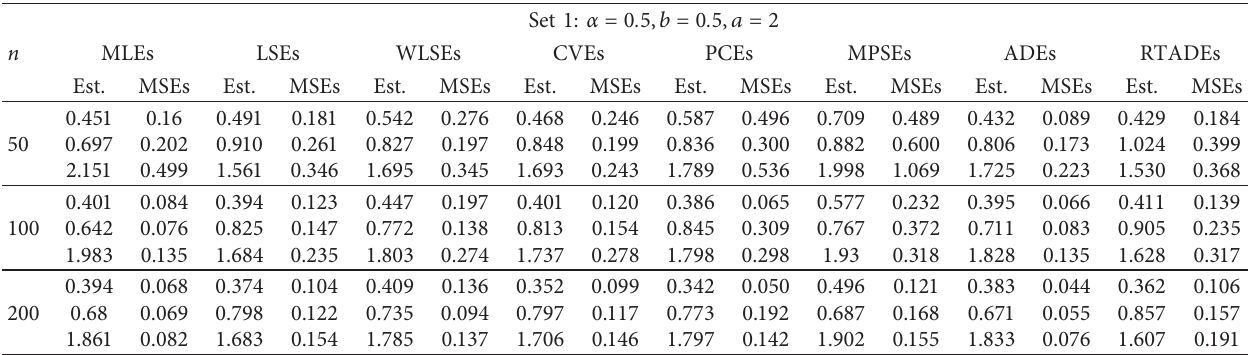
Table 2: Estimates and MSEs of APTIL distribution for ML, LS, WLS, CV, PC, MPS, AD, and RTAD estimates for set 2. n